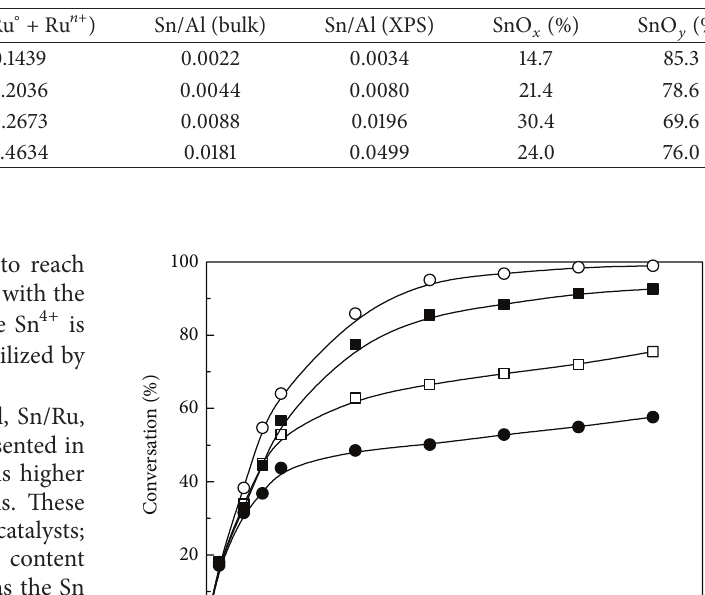
Table 2: Surface XPS atomic ratios of the metal species on the bimetallic catalysts.